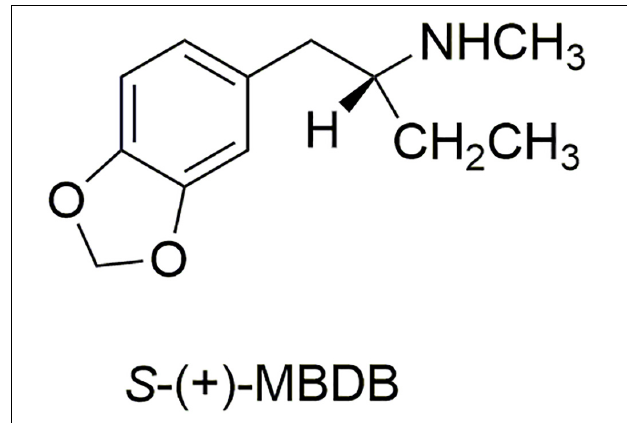
FIGURE 3 | The structure of the more active enantiomer S